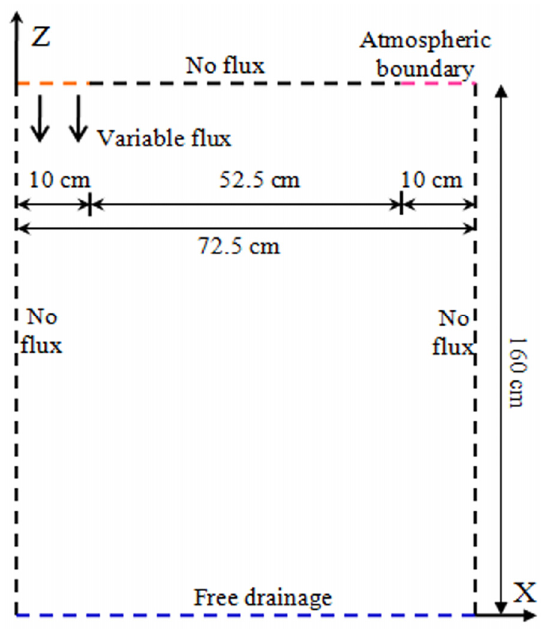
Figure 2. Positions of different boundary